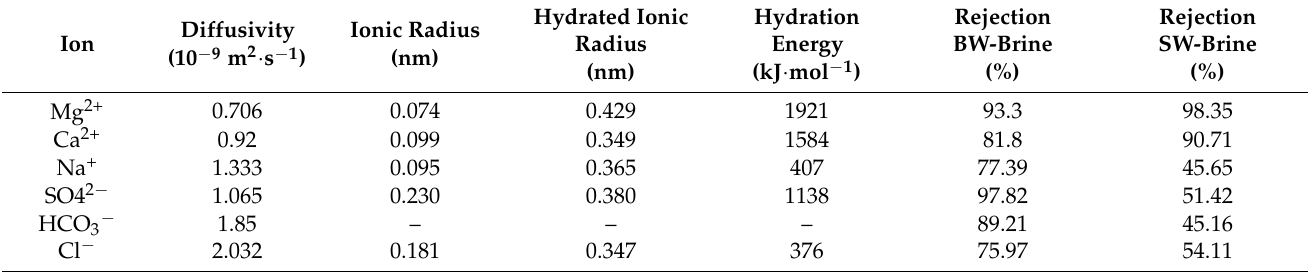
Table 4. Some parameters and rejection percentages of the ions in water and their rejection using NF membrane [48,61,62].